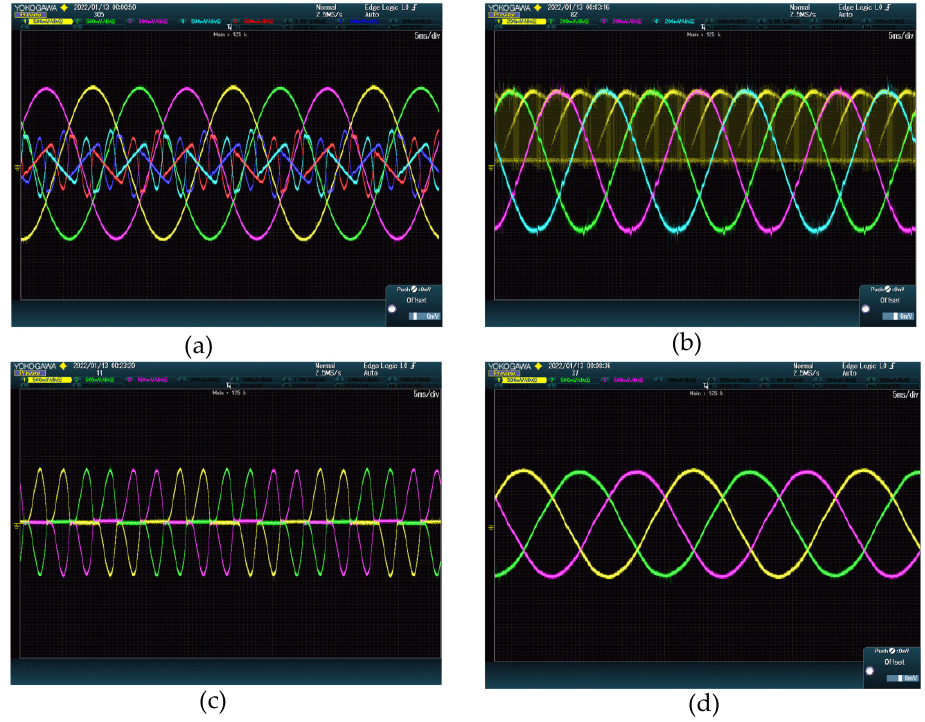
Figure 15. Oscilloscope image of the results of case study 1/scenario B. From left to right, top to bottom: ( a ) diesel generator phase voltages and currents; ( b ) battery currents (at the battery itself and at the output of the filter); ( c ) input currents to the propulsion system; ( d ) stator currents of the induction